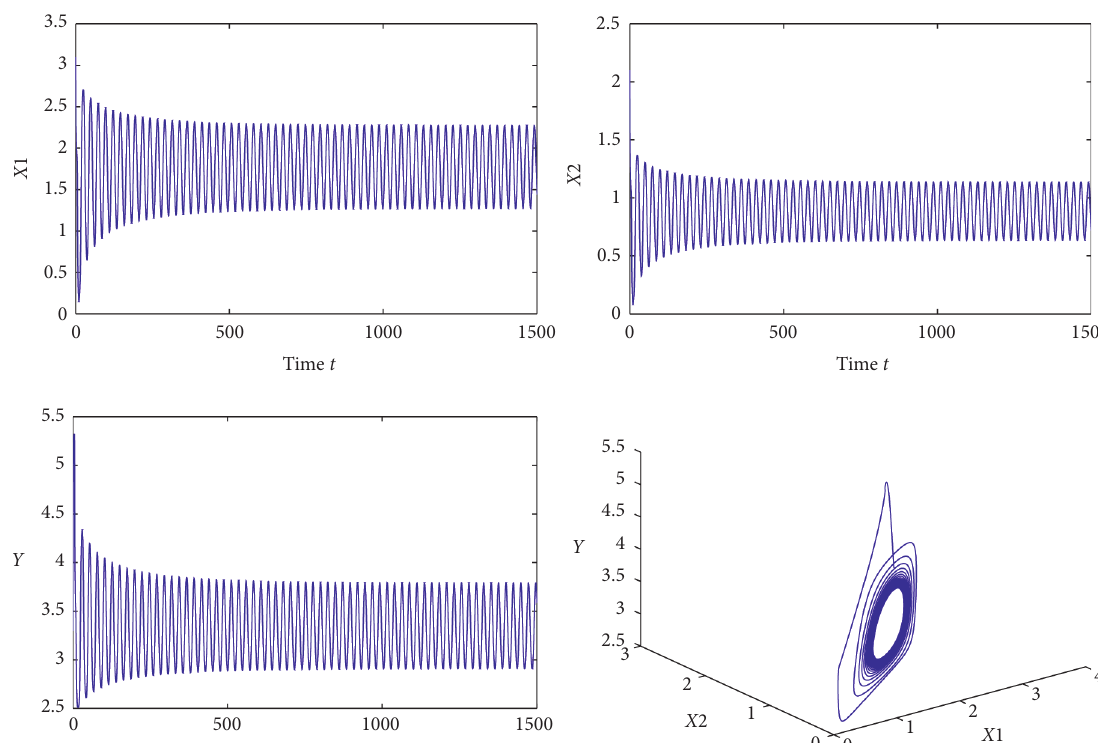
Figure 3: τ � 4 . 25 > τ . The bifurcation periodic solution is 0